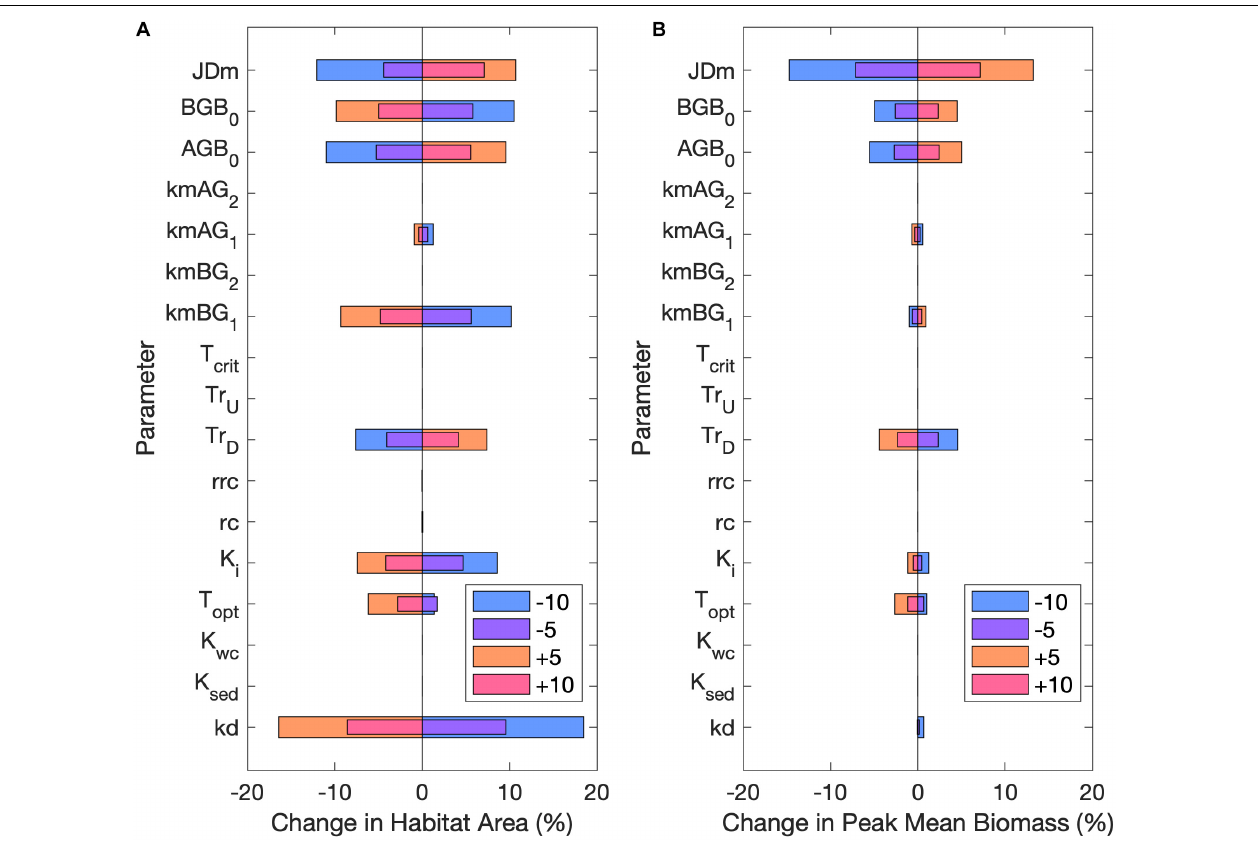
FIGURE 7 | Percent change in (A) habitat area and (B) peak mean biomass from the base case for ± 5 and ± 10 of all parameters in sensitivity analysis. Legend unit is percent for all parameters expect JDm , which is in days. Refer to Table 2 for parameter